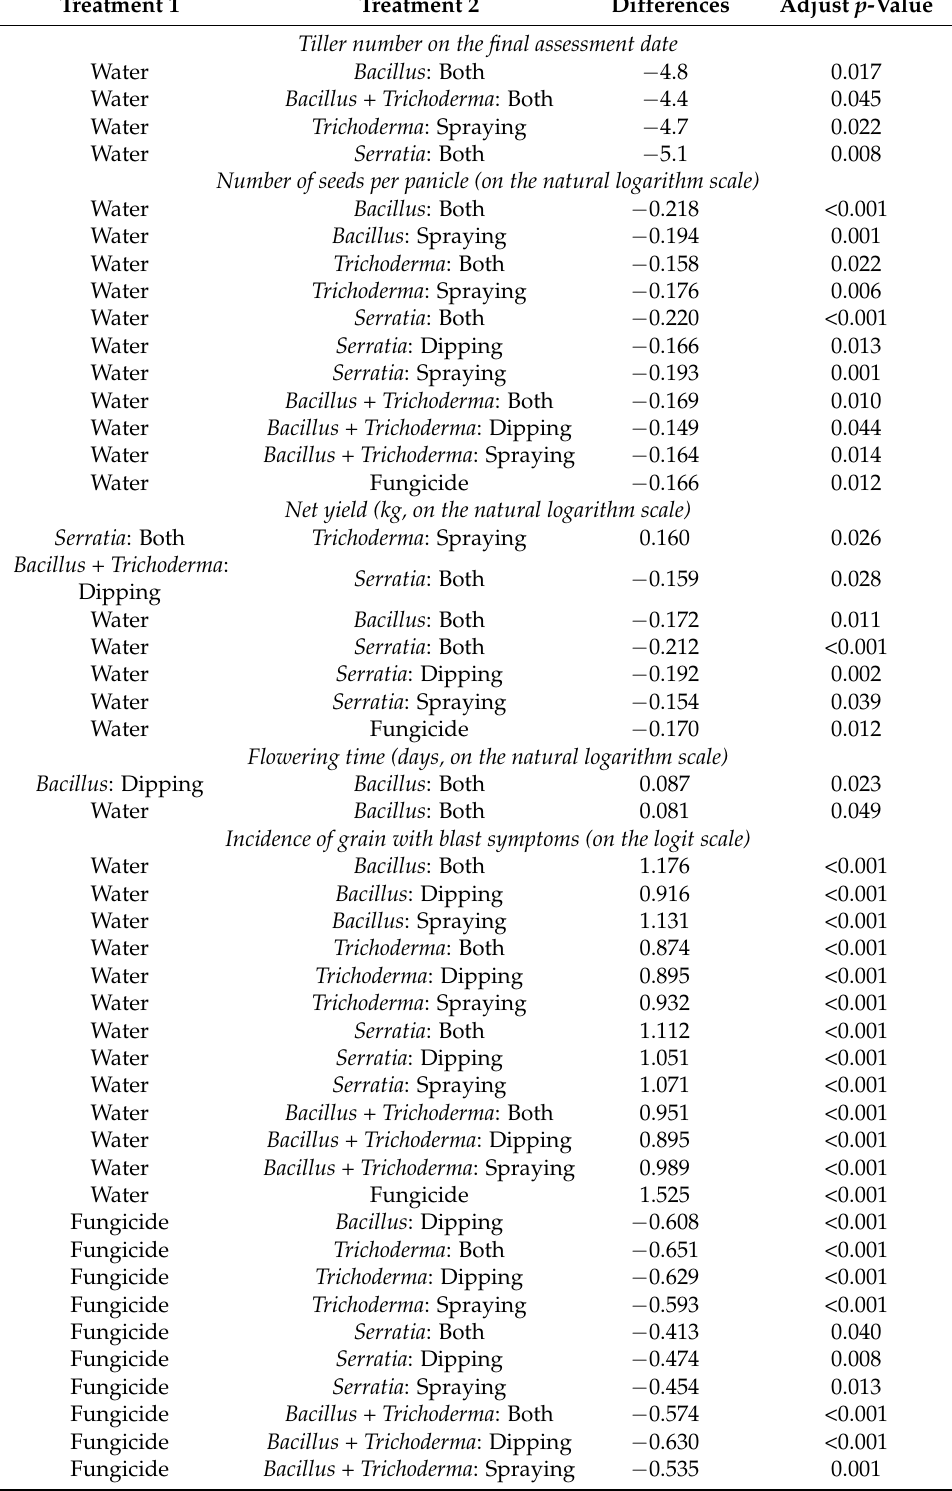
Table 2. Significant pairwise comparisons for all 14 treatments applied to rice plants at one trial site in Kenya across 2020 and 2021, based on the Tukey HSD test, with the p -value adjusted for multiple comparisons [26]. The 14 treatments included four biopesticides, each applied as dipping at transplanting, post-transplanting foliar spraying, or both, and two controls (water and